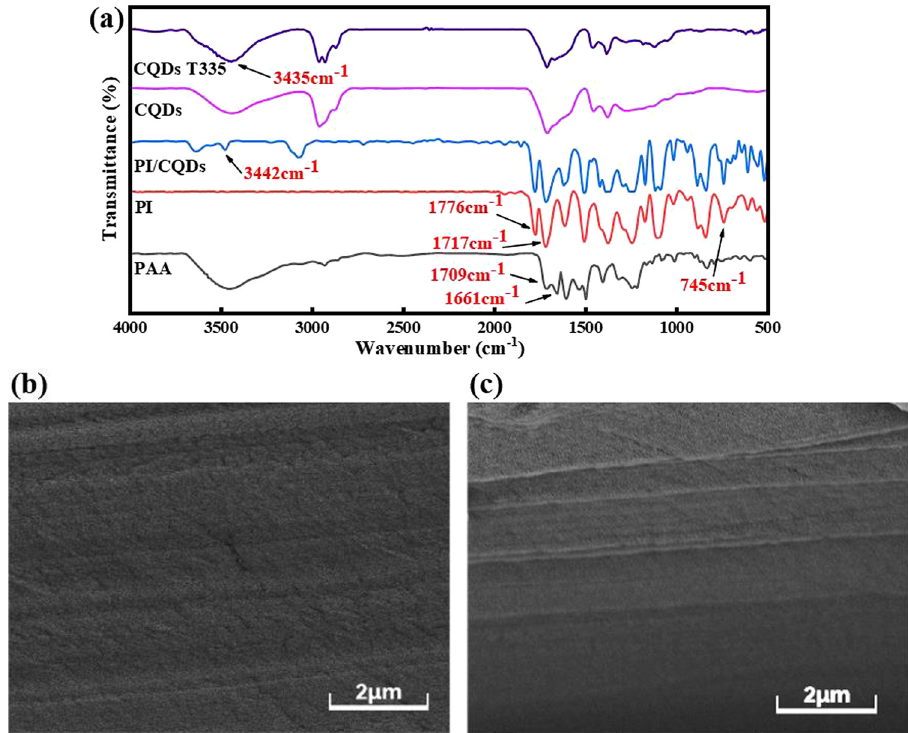
Figure 4: ( a ) FT - IR spectra of PAA, PI, PI/CQDs, ( b ) SEM image of the PI fracture surface, and ( c ) SEM image of the PI/CQD fracture